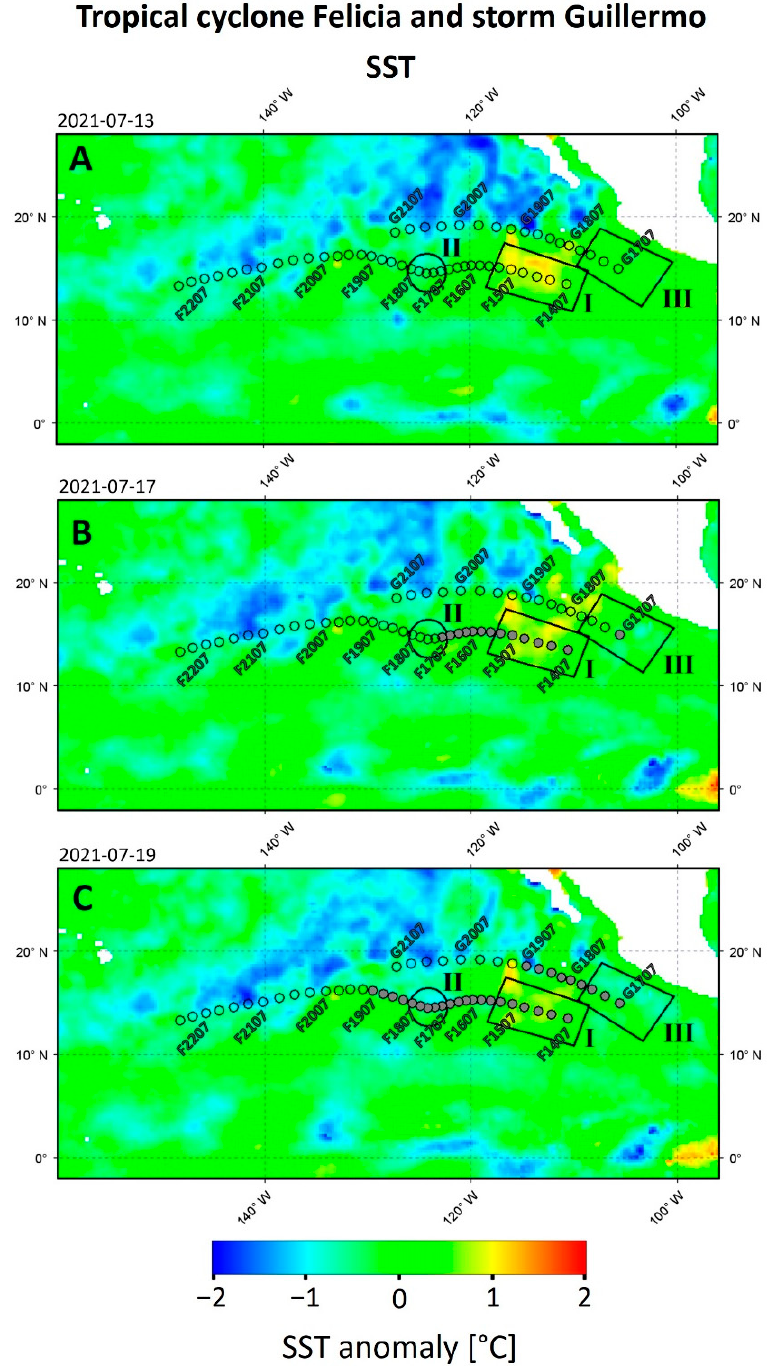
Figure 3. Anomaly maps for SST in the study area of TC Felicia and tropical storm Guillermo for ( A ) 13 July 2021, ( B ) 17 July 2021 and ( C ) 19 July 2021. Anomalies are color-coded as indicated by the color bar. Tracks are marked with circles. Open circles indicate that the storm has not yet passed the position. The labels along the track indicate position of TC Felicia (F) and storm Guillermo (G) on a particular day and month, e.g., F1407 or G1707. The dates of satellite images are given on the top left of each panel. White space indicates areas without data.